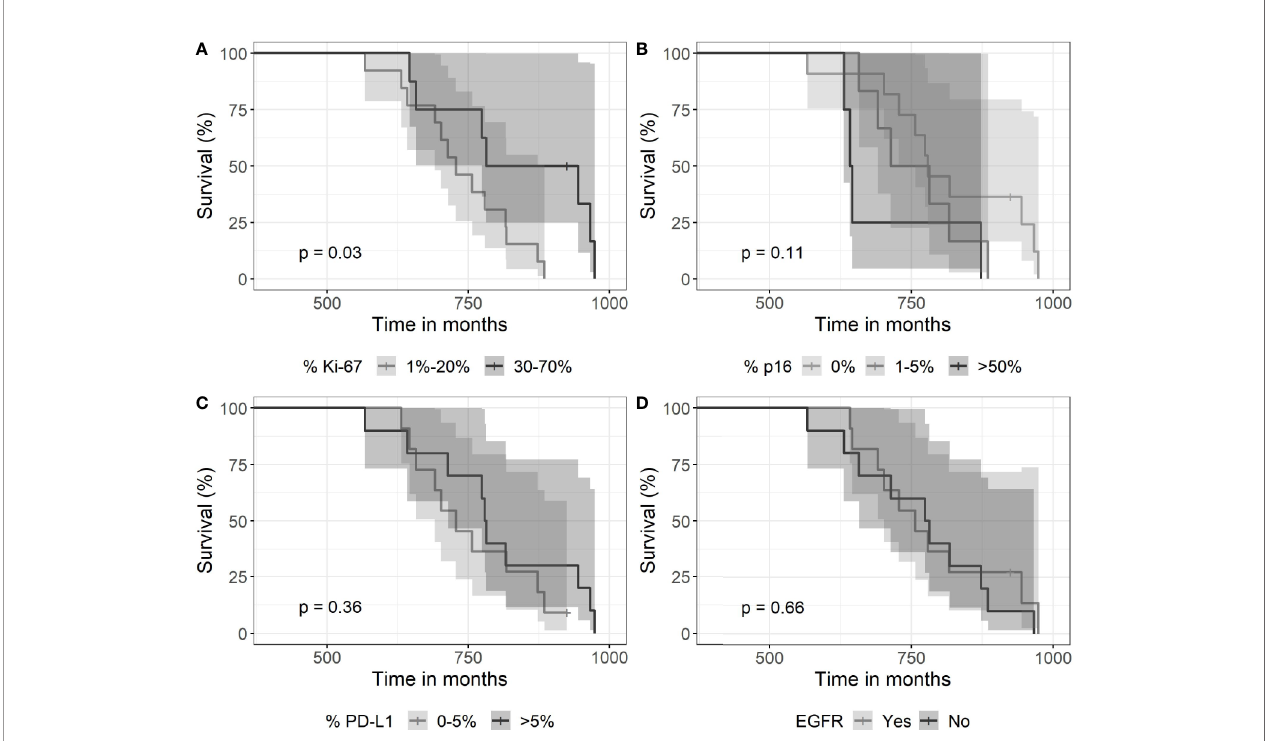
FIGURE 5 | Kaplan-Meier curves for survival as a function of molecular markers. (A) Expression of >30% of Ki67 — associated with longer survival (p=0.03). (B) The expression of p16 did not associate with survival (log-rank test with a p-value of 0.11), (C) neither did a high expression of PDL-1 (p=0.36), nor (D) EGFR (immunohistochemistry) expression